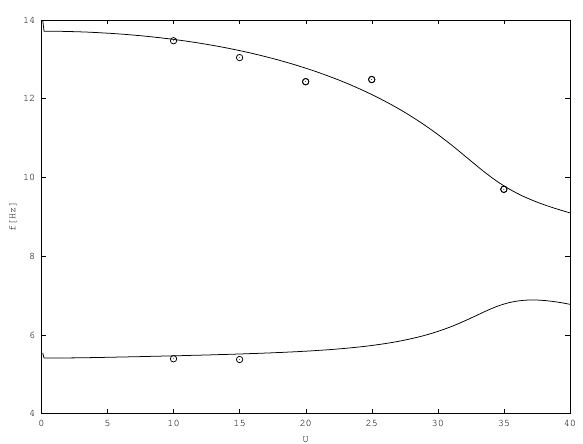
Fig. 3. The frequency of vibrating airfoil in dependence on the far field velocity U ∞ for the first considered aeroelastic prob- lem. The results obtained by the linearized aerodynamical the- ory (solid line) and by the finite element method (symbols) are shown.